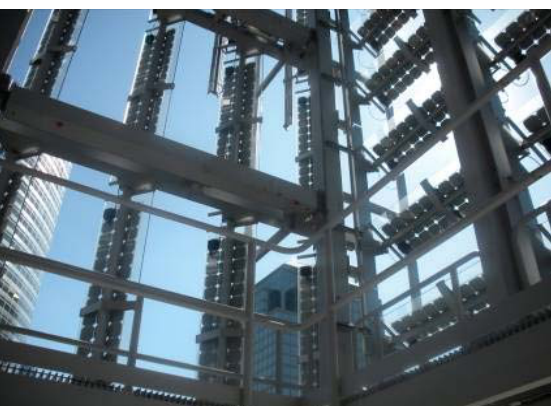
Figure 8. The Riverhouse dynamic PV system